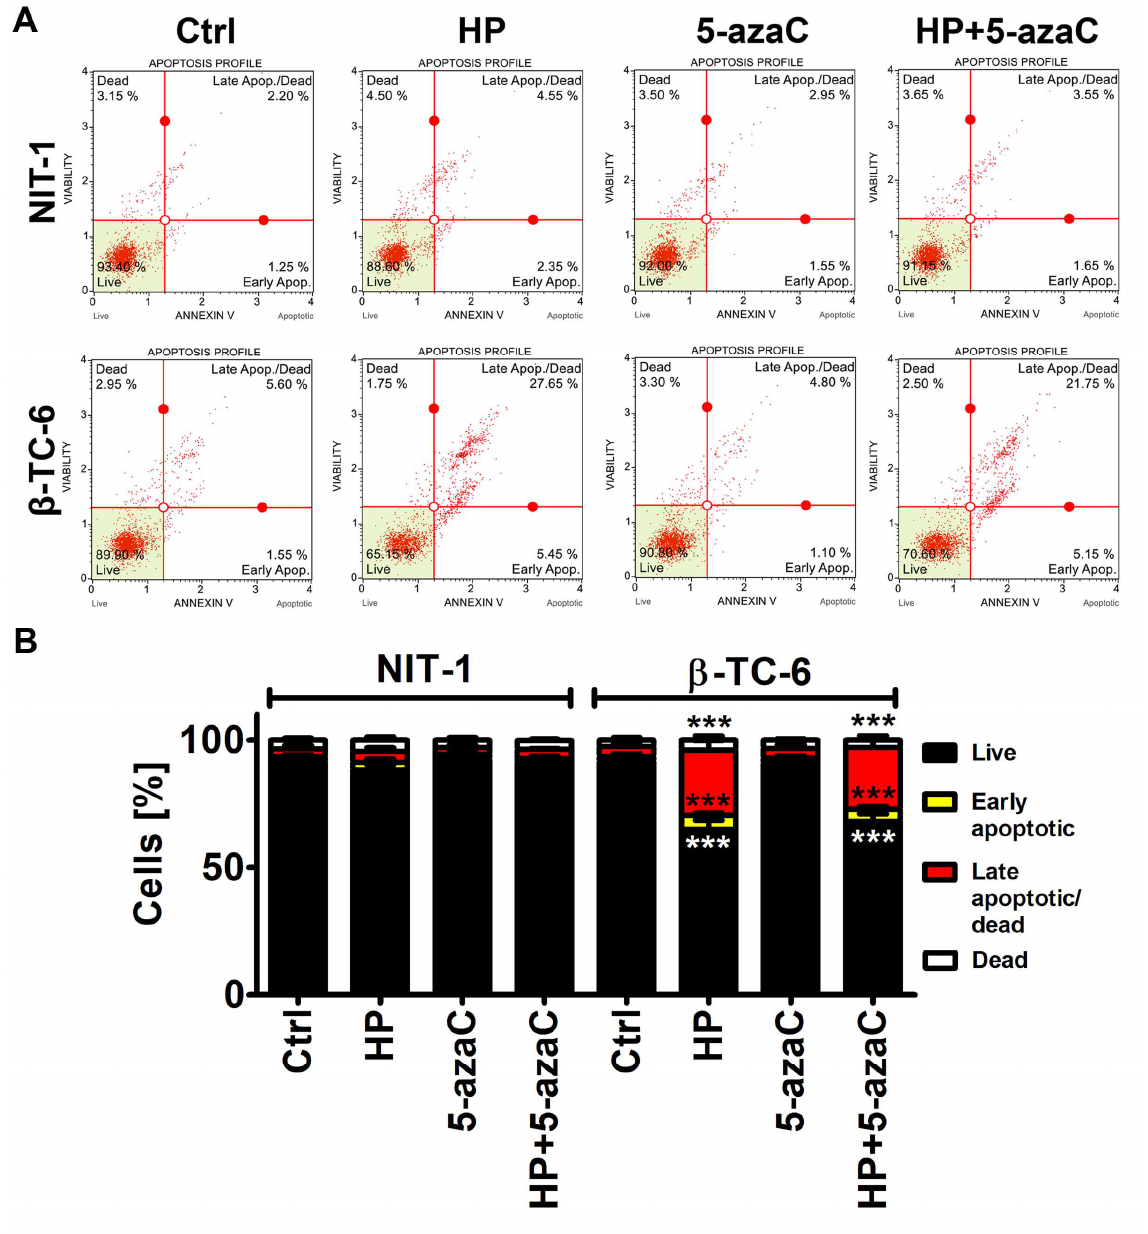
Figure 2. 5-AzaC post-treatment-mediated apoptosis in hydrogen peroxide-treated mouse insulinoma NIT-1 and β -TC-6 cells. Insulinoma cells were stimulated with 100 µ M HP for 24 h and then post-treated with 1 µ M 5-azaC for 24 h. Apoptosis was evaluated using Annexin V staining and flow cytometry. ( A ) Representative dot plots are shown. ( B ) Bars indicate SD, n = 3, *** p < 0.001 compared to Ctrl (ANOVA and Dunnett’s a posteriori test). Ctrl, control conditions; HP, hydrogen peroxide (H 2 O 2 ) treatment; 5-azaC, azacytidine treatment; HP+5-azaC, hydrogen peroxide treatment, and azacytidine post-treatment.